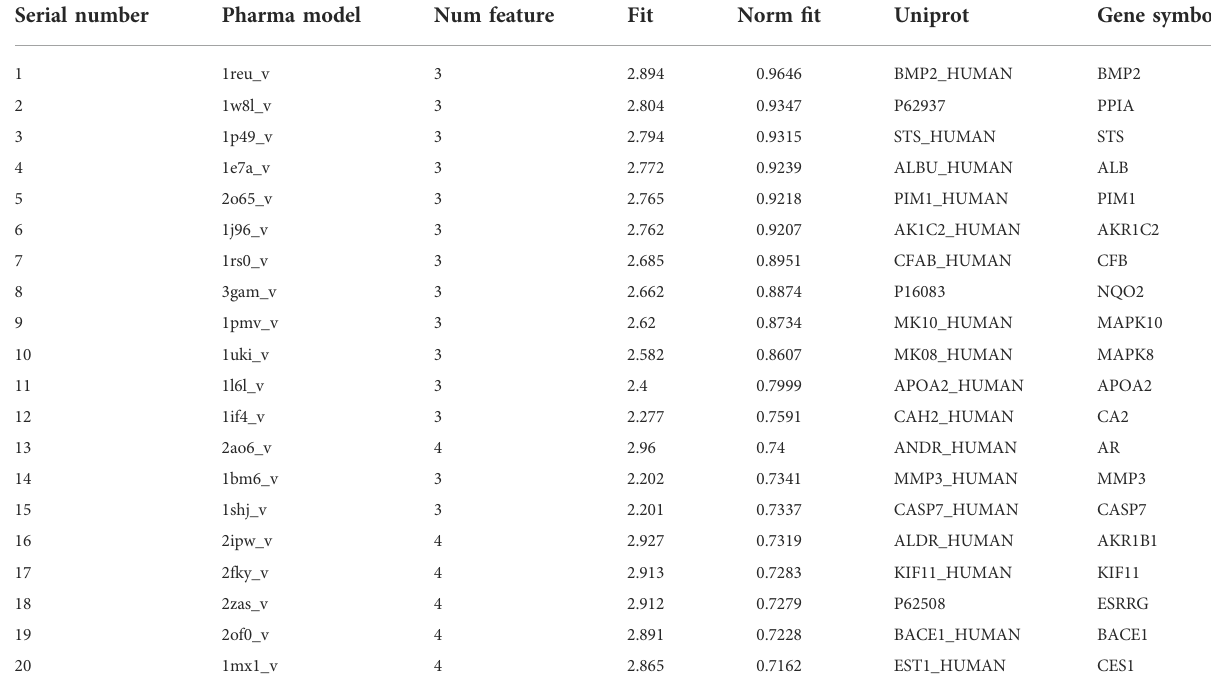
TABLE 2 Potential mutual targets of